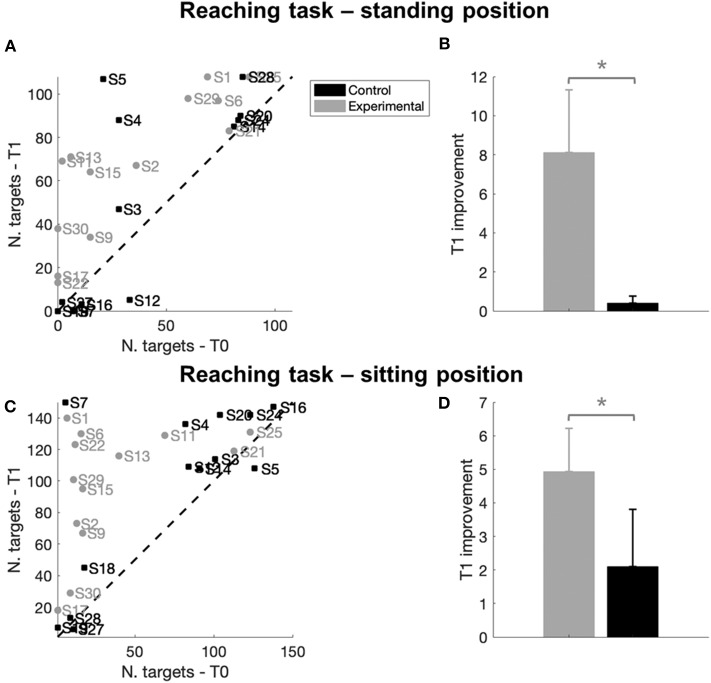
Reaching task results. (A–C) Number of targets reached at T0 and T1 for each subject in the standing (A) or sitting (C) trial. Different colors represent different groups: gray indicates a subject of the experimental group while black represents a subject of the control group. The dashed line represents the line of equality, where the number of targets reached before (T0) and after the treatment (T1) was identical. A data point located above the equality line (in the upper left side of the graph), indicates that a subject reached a bigger number of targets at the end of the treatment T1 than at T0, thus indicating an improvement in movement control. The opposite would hold for a point under the equality line (in the lower right side of the graph). (B–D) Improvement at T1 with respect to T0 in the number of reached targets in a 5-min period computed as T1-T0/T0, respectively in the standing (B) or sitting (D) trial. Error bars indicate Standard Errors; * indicate p < 0.05.